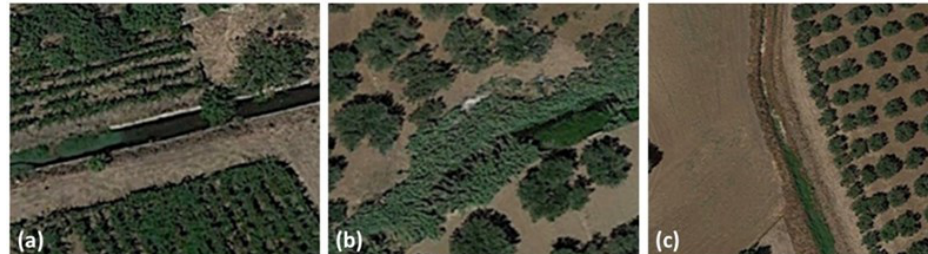
Figure 4. Orthophoto frames of three different channel portions: ( a ) flowing water filling the entire cross-section of the riverbed nearby the effluent outlet; ( b ) flourishing riparian vegetation indicating a wet riverbed; ( c ) transition from a wet to a dry streambed condition suggested by a colour change from vivid green to light brown.